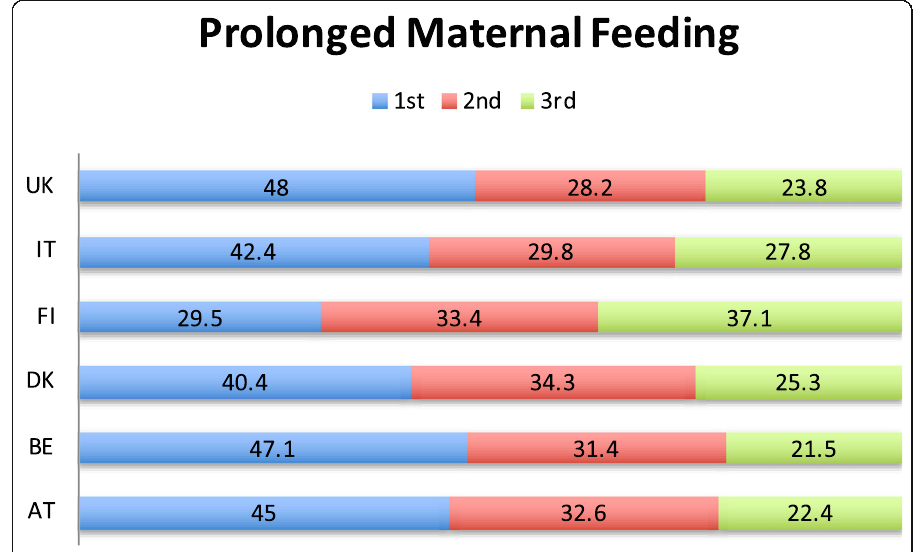
Fig. 4 Ranking of ‘ prolonged maternal feeding ’ by country